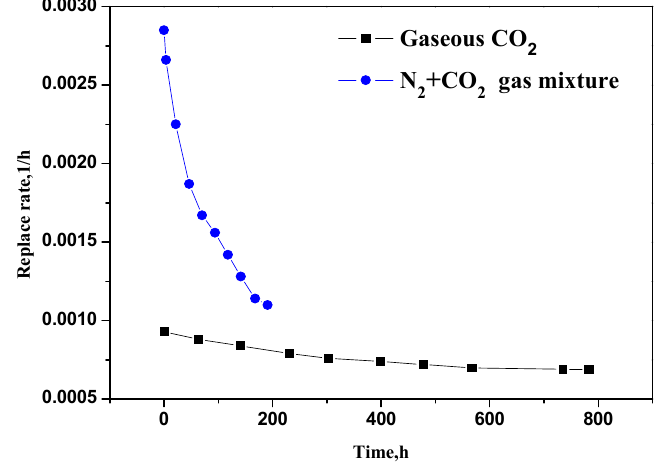
Figure 6. Variation of the replacement rate with elapsed time for different replacement gases.